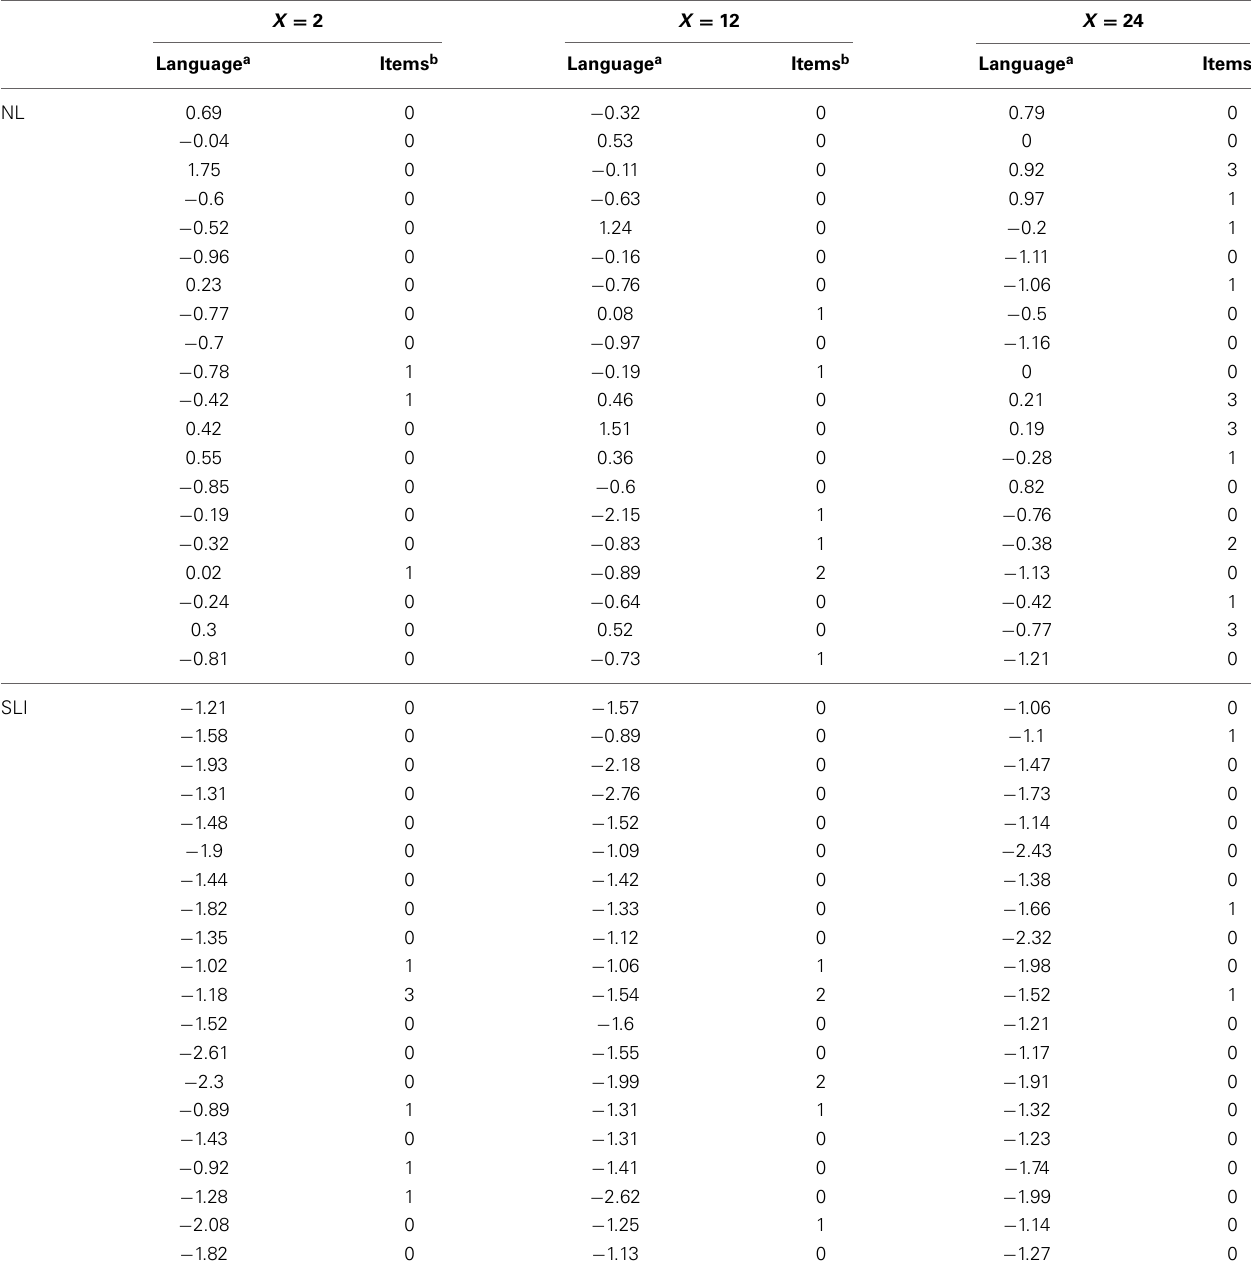
Table A2 | Language composite scores and number of non-adjacent pairs learned (100% accuracy) for each participant in the three conditions. X = 2 X = 12 X = 24 Items b Language a Items